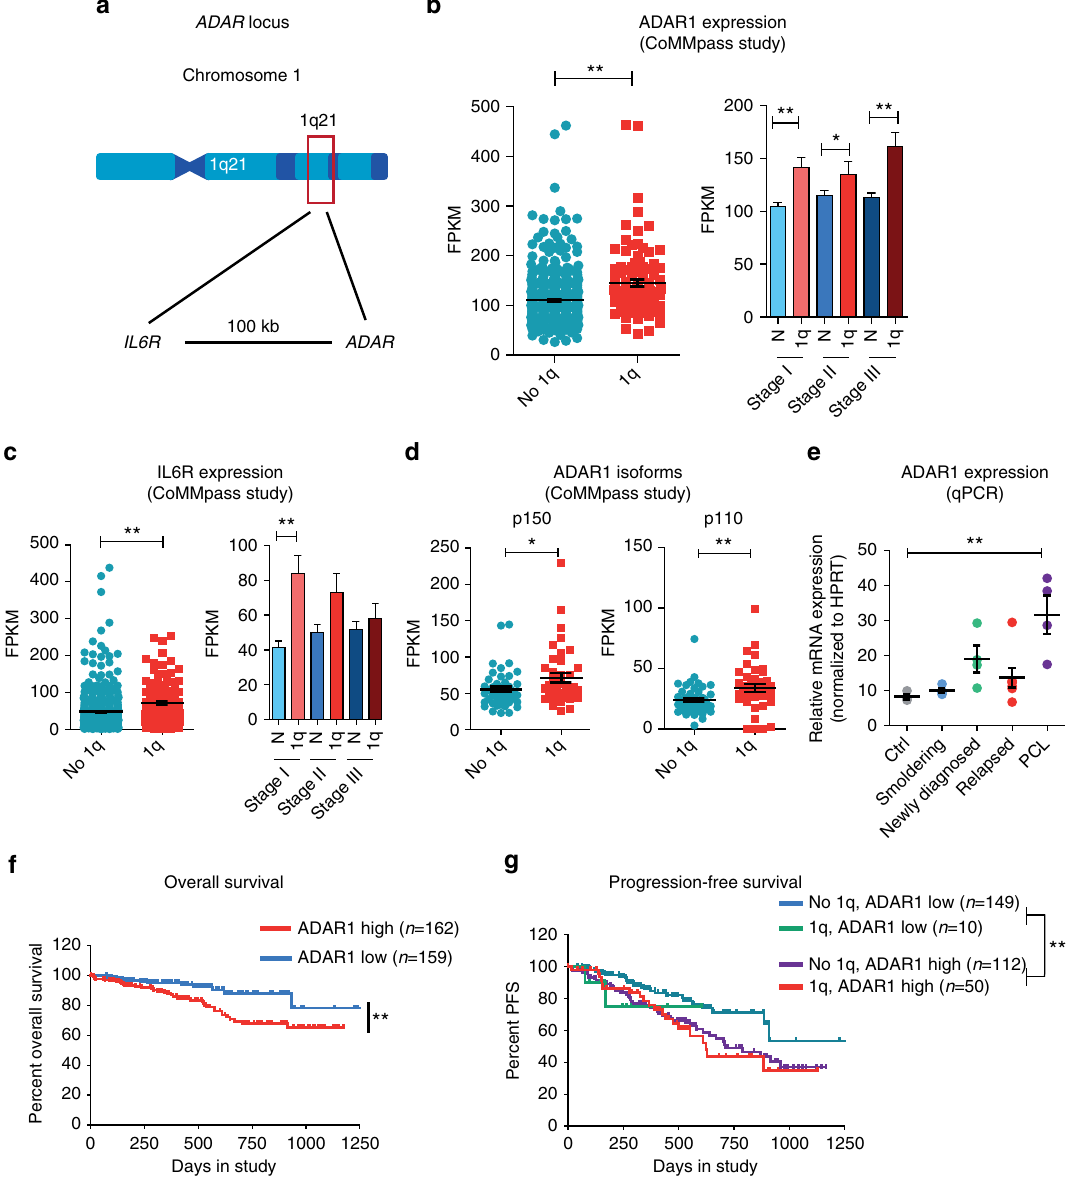
Fig. 1 ADAR1 is overexpressed in high-risk, advanced MM patients. a Representative diagram of ADAR genomic locus on chromosome 1q21. b ADAR1 relative expression (Fragments Per Kilobase of transcript per Million mapped reads, FPKM) in primary CD138 + cells from patients harboring 1q ampli fi cations, compared to no 1q (1q stage I n = 29, stage II n = 39, stage III n = 32; no 1q stage I n = 146, stage II n = 150, stage III n = 133). The error bars represent ± S.E.M. of the mean; ** p < 0.01 by two-tailed, Mann – Whitney U test. c IL6R relative expression in primary CD138 + cells from patients harboring 1q ampli fi cations, compared to no 1q. The error bars represent ± S.E.M. of the mean; ** p < 0.01 by two-tailed, Mann – Whitney U test. d ADAR1 isoform relative expression in 1q-ampli fi ed (1q) versus no 1q patients. The error bars represent ± S.E.M. of the mean; * p < 0.05, ** p < 0.01 by two-tailed, Mann – Whitney U test. e Total ADAR1 mRNA levels assessed in total MNCs from primary samples ( n = 19; see Table 1). Age-matched ( n = 3, mean age = 60.6 ± 16.8 years old) BM collected from patients undergoing hip replacement therapy for reasons other than cancer were used as normal healthy controls. HPRT gene expression was used for normalization. Dots represent mean values for individual patients ± S.E.M (ctrl n = 3; smoldering MM n = 4; newly diagnosed MM n = 4; relapsed MM n = 7; PCL n = 4). ** p < 0.01 compared to normal controls by unpaired, two-tailed Student ’ s t -test. f Kaplan – Meier curves for overall survival (OS) of high ( n = 162) versus low ADAR1 ( n = 159) expressing cohorts in the CoMMpass (IA8) study ( n = 643). ** p < 0.001 by Cox regression. g Kaplan – Meier curves for progression-free survival (PFS) of high (top 25% ADAR1) versus low ADAR1 (bottom 25% ADAR1) expressing cohorts in the CoMMpass (IA8) study ( n = 643), further strati fi ed into 1q or no 1q cohorts. ** p < 0.001 by Cox regression. Statistical signi fi cance was indicated when p < 0.05. See also Supplementary Fig.